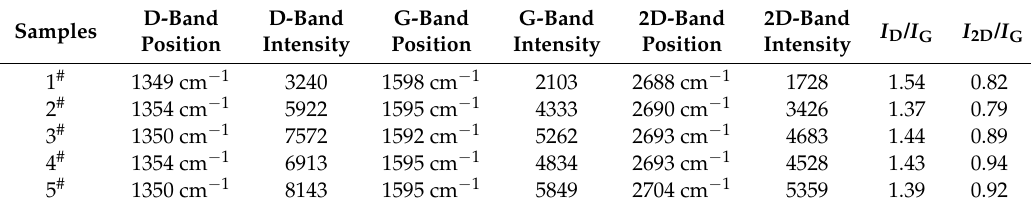
Figure 1. Raman spectra of graphene from samples of 1 # –5 # . Table 3. Raman intensity for I D , I G , I 2D , and the ratio of I D / I G and I 2D / I G from Figure 1.